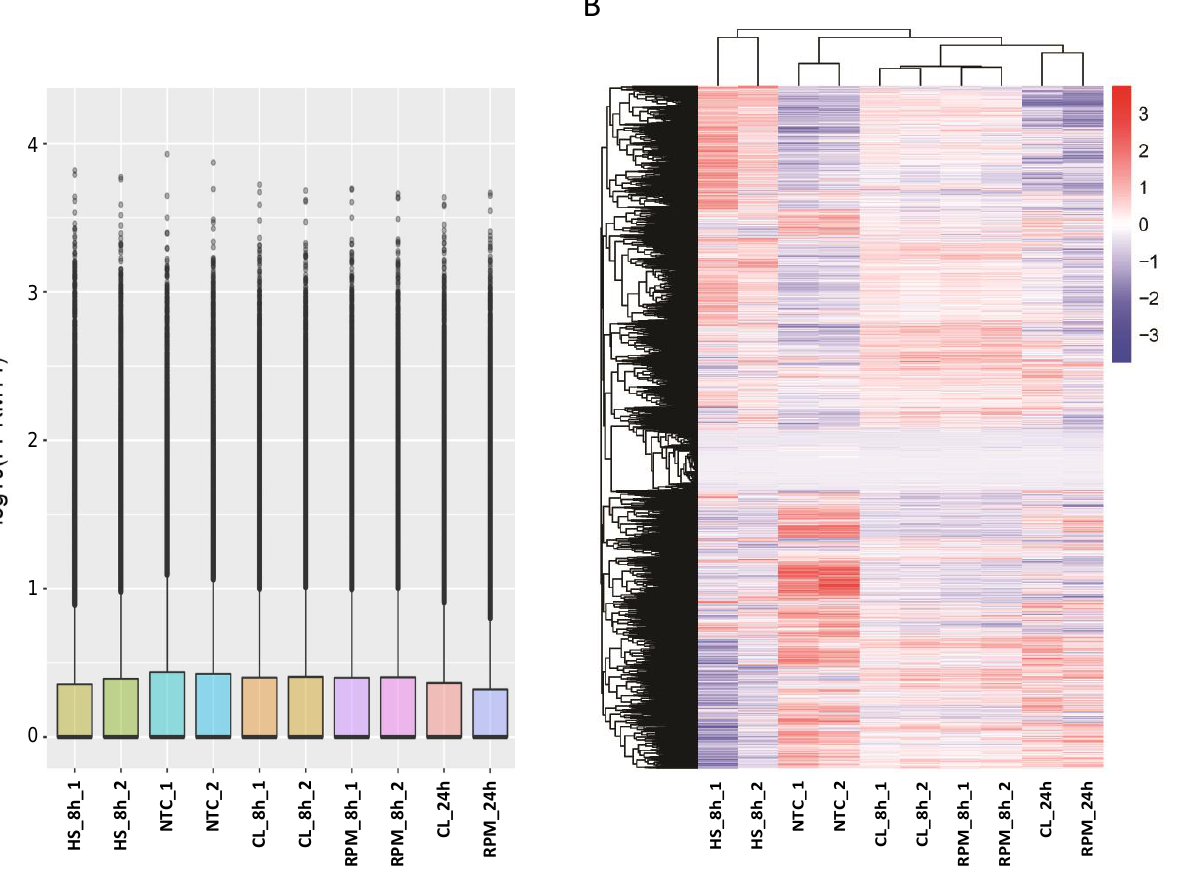
Figure 2. The overview of global transcriptome expression in RNA-seq samples (mouse T cells). ( A ) FPKM distribution in RNA-seq samples . Boxplot demonstrates the FPKM distribution in RNA- seq samples, the x -axis shows the sample names and the y -axis shows the log 10 (FPKM + 1) value. ( B ) Heatmap of clustering of differential gene expression in RNA-seq samples. The hierarchical cluster analysis was used to observe gene expression patterns under SMG or HS experimental conditions versus NTC. The color scale from red to blue represents the log 10 (FPKM + 1) value from high to low gene expression